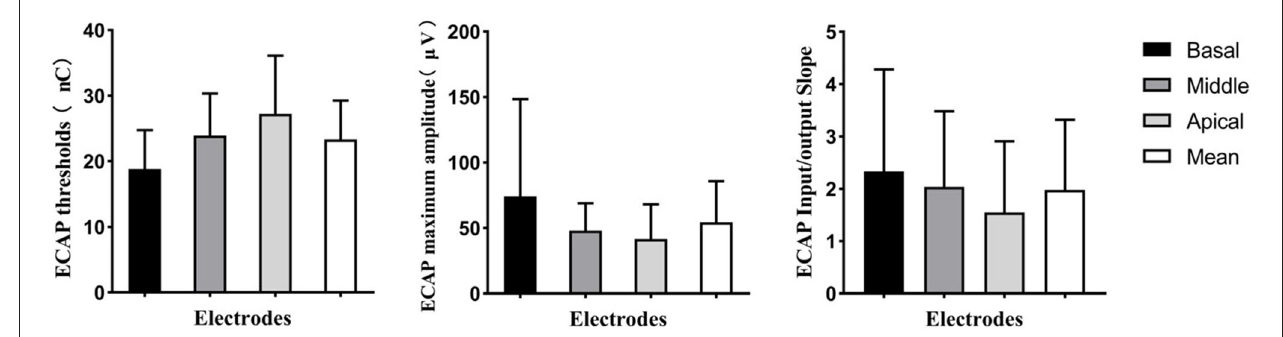
FIGURE 4 | Means and standard deviations for ECAP threshold, maximum ECAP amplitude, and slope of the ECAP input/output function for basal, middle, and apical electrodes. The mean value of the ECAP at these three electrodes is also shown. ECAP, electrically evoked compound action potential.